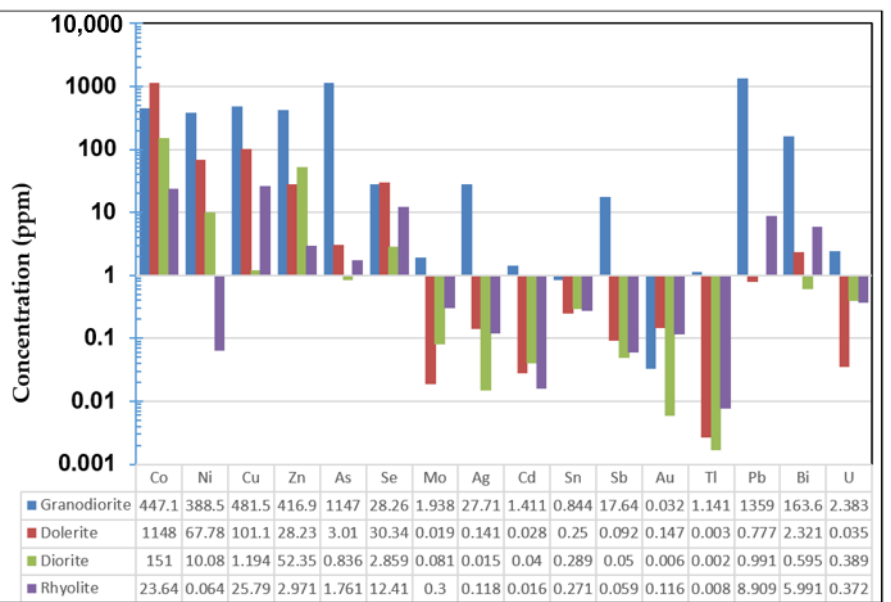
Figure 16. Chart showing variations in trace element contents across igneous ‐ rock hosted pyrites. Diorite ‐ hosted pyrites have the lowest gold content. At the bottom, the diagram which is combined with the legend shows the mean values of each element found in the collected samples.